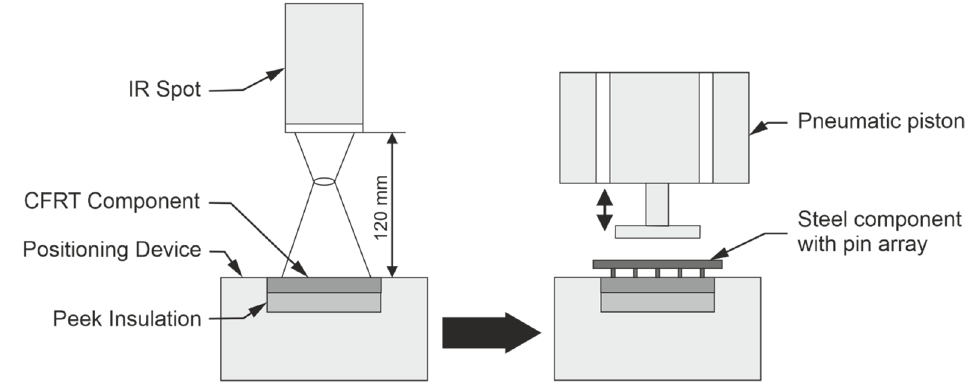
Figure 4: Illustration of joining apparatus.